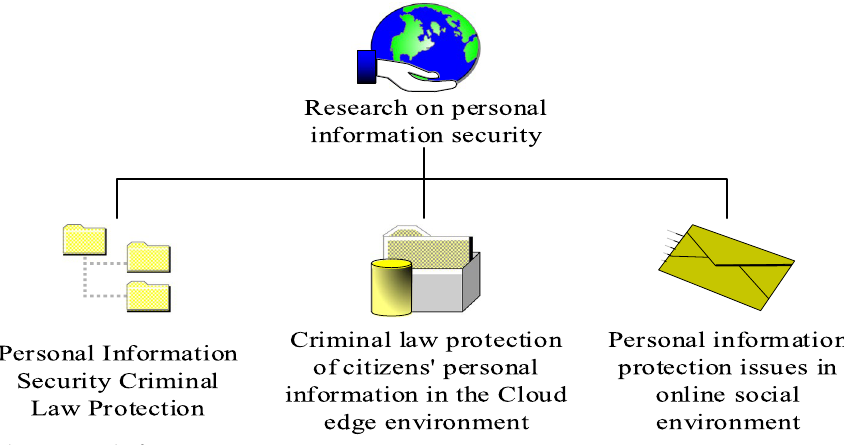
Fig. 1 Research trends on personal information